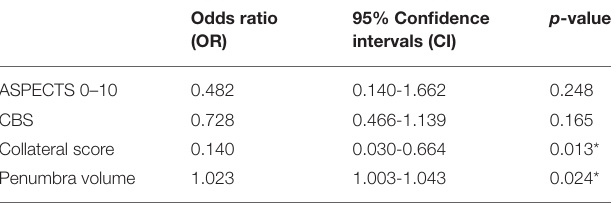
TABLE 3 | Predictors of patient